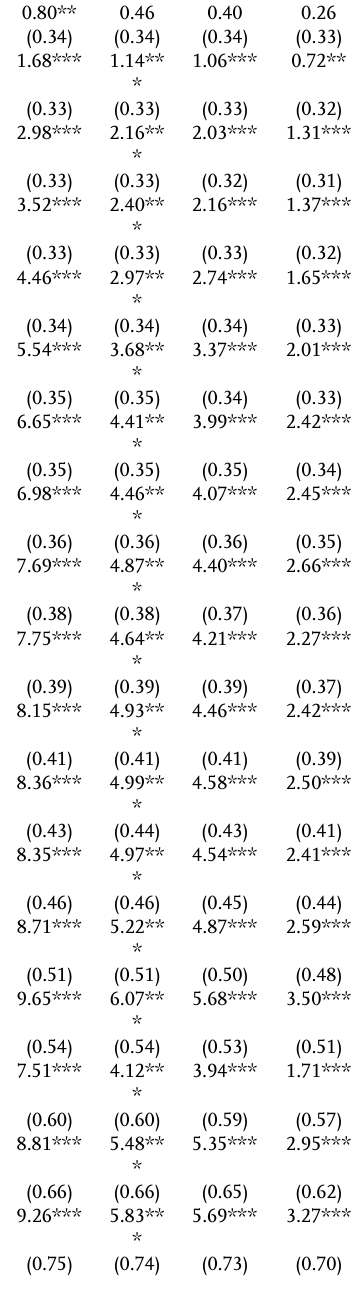
Table A.1 : Earned income, spacing and interaction terms (continued) Mothers age